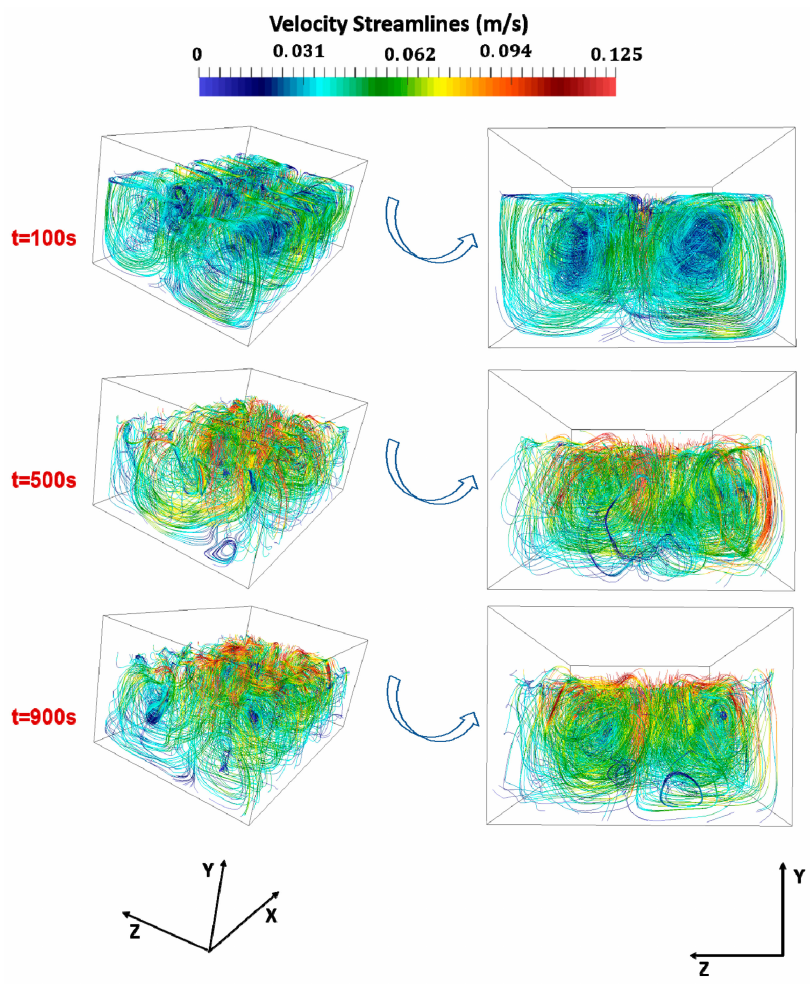
Figure 6. Stream traces of the fuel for the four inlet case at three different times. The left column shows a perspective view of the fuel tank and the right column shows a view along the width of the